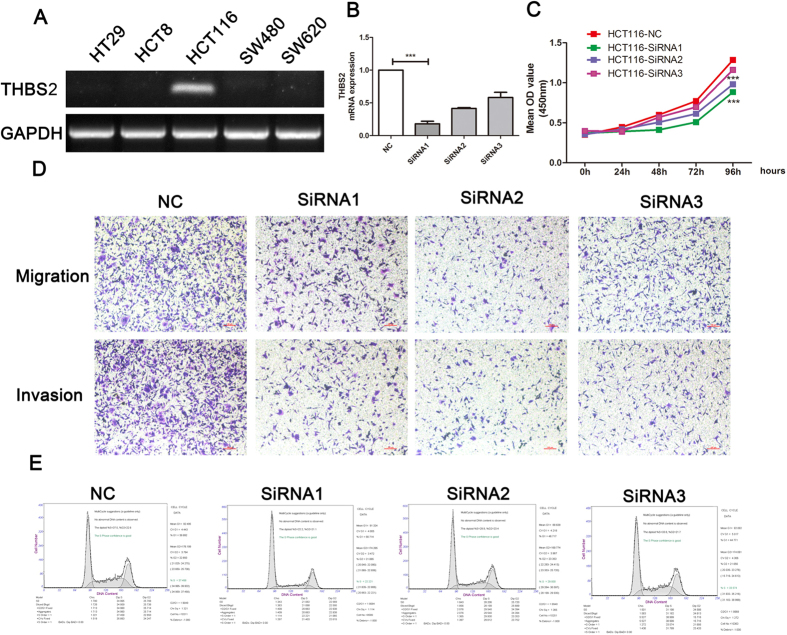
THBS2 promotes proliferation and metastasis in HCT116 cell.(A) The expression of THBS2 in colorectal cancer cell lines. (B) Detection of THBS2 in HCT116 cell with THBS2 knockdown by qRT-PCR. (C) Cell proliferation for HCT116 with THBS2 knockdown. (D) Migration and invasion assay for HCT116 with THBS2 knockdown. (E) Cell cycle with THBS2 knockdown.